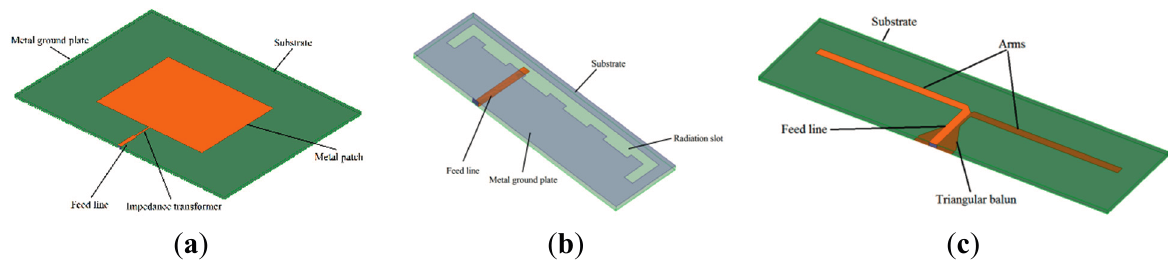
Figure 10. Structure of 3 common antennas: ( a ) MPA; ( b ) MSA; ( c )